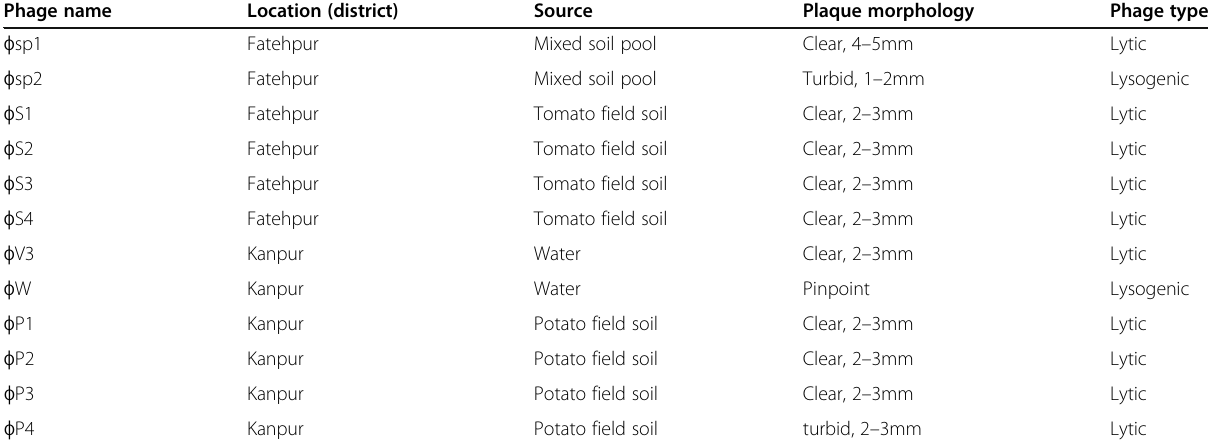
Table 1 List of isolated bacteriophages for host Ralstonia solanacearum strain 1629 used in this study